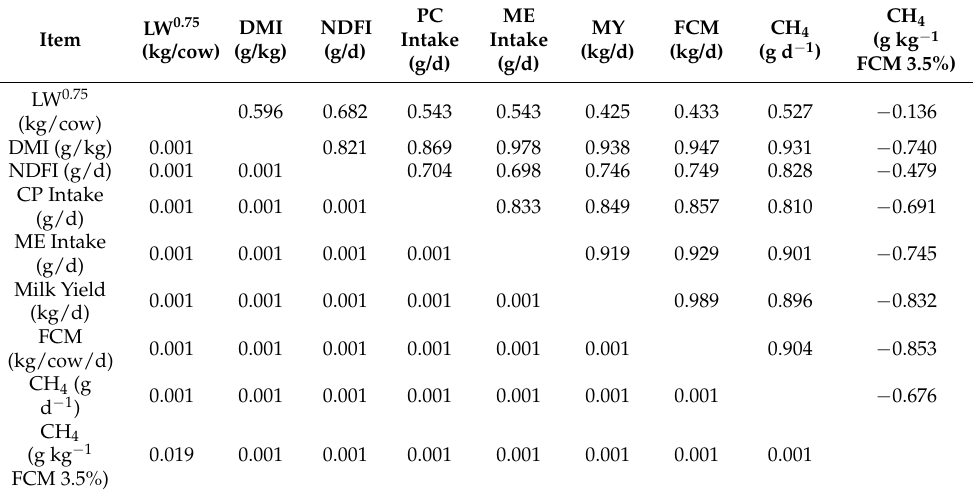
Table 8. Correlations among nutrient intake, emissions of methane (CH 4 ) of different feeding strategies in dairy cattle in small dairy farmers under different feeding management systems.